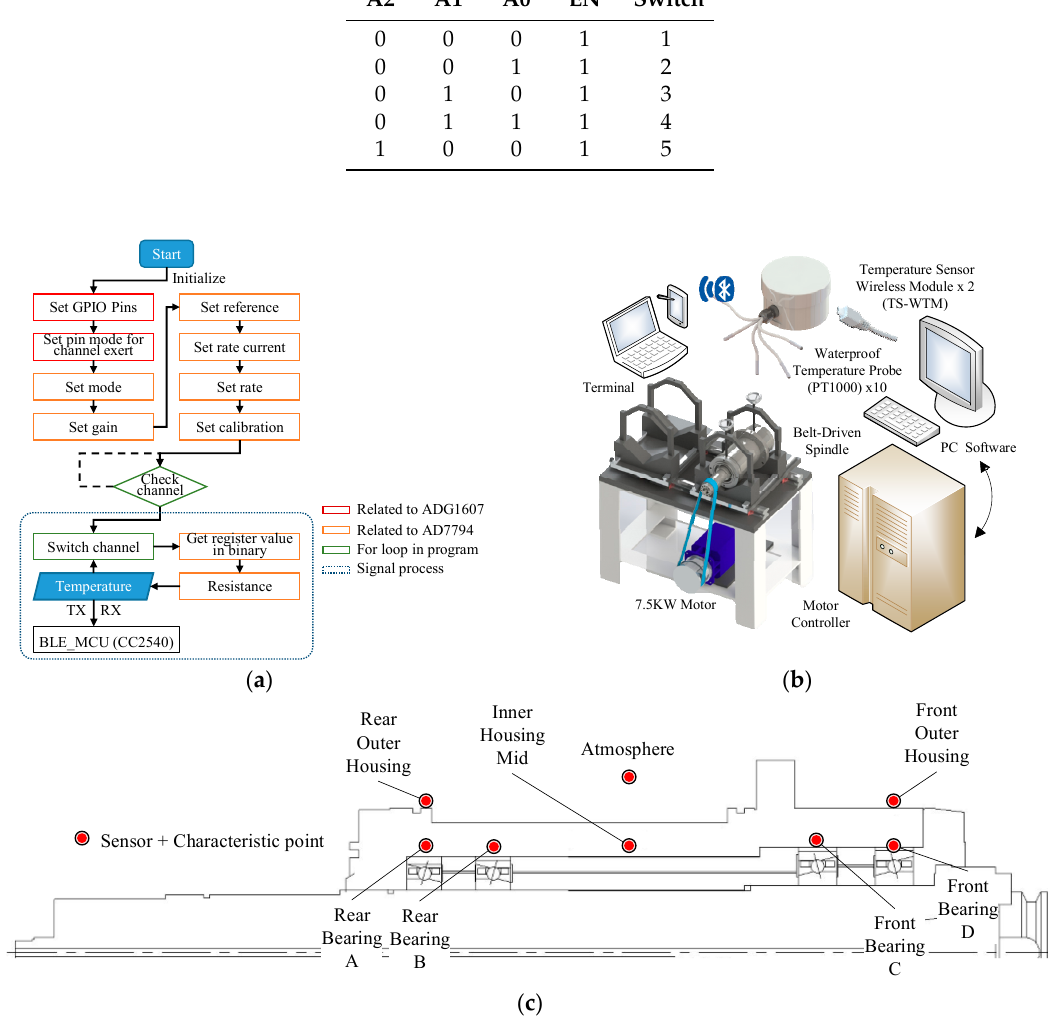
Table 1. Part of the ADG1607 truth table [18].